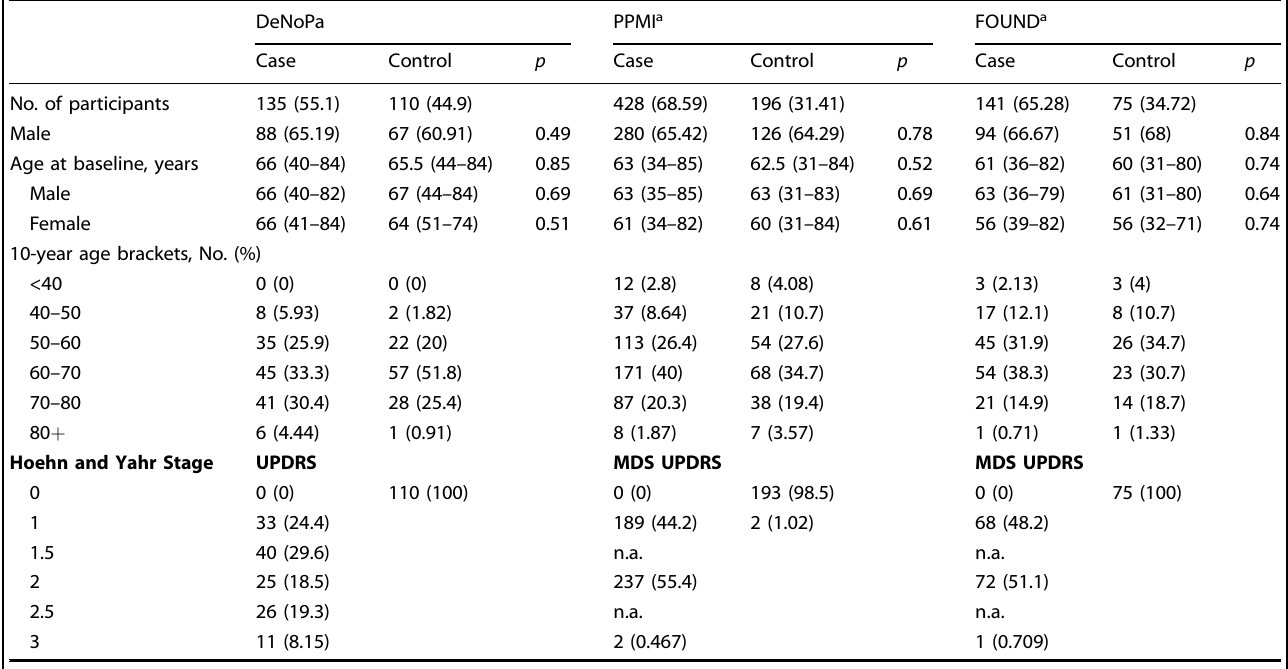
Table 1. Demographic characteristics of adults enrolled in the single-centre DeNoPa and multi-centric PPMI (and FOUND) cohorts. DeNoPa PPMI a FOUND a